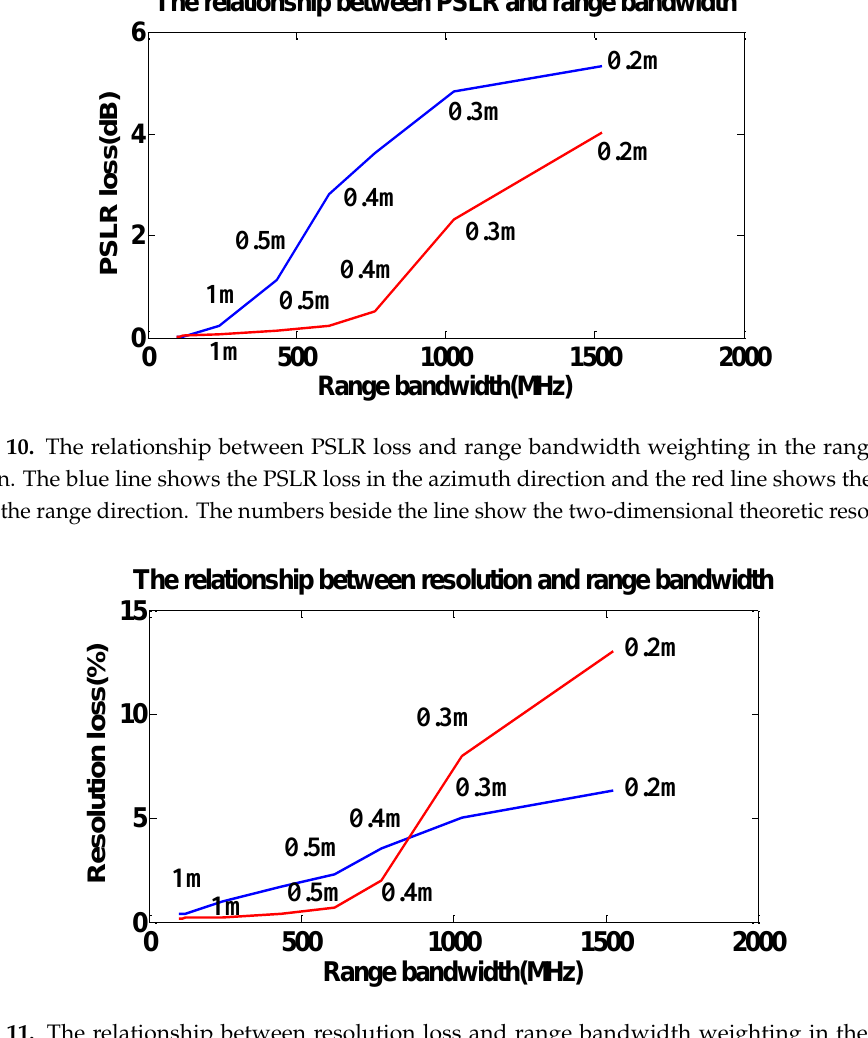
Figure 11. The relationship between resolution loss and range bandwidth weighting in the range time domain. The blue line shows the resolution loss in the azimuth direction and the red line shows the resolution loss in the range direction. The numbers beside the line show the two-dimensional theoretic resolution.